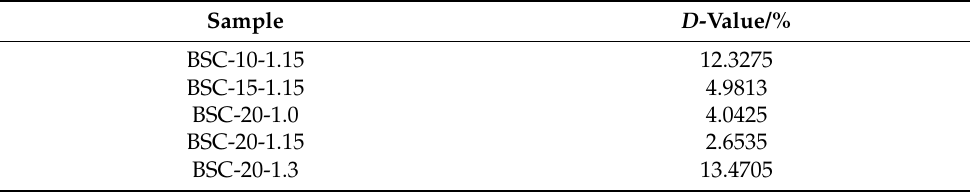
Table 3. D -values of BSC